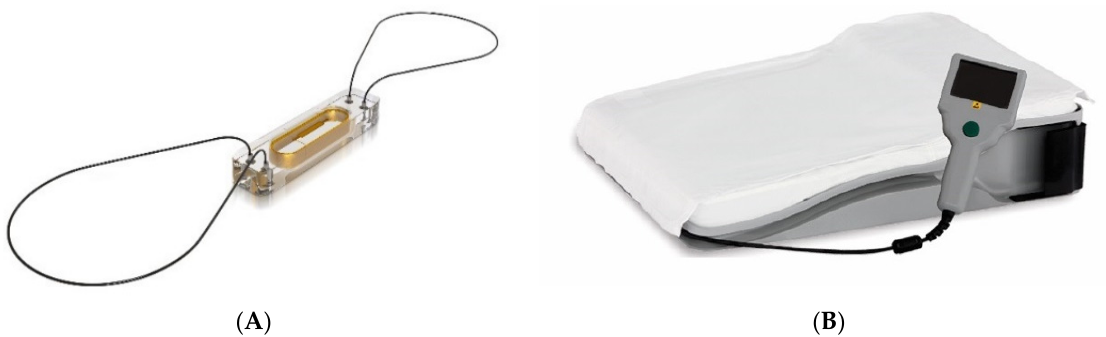
Figure 6. The CardioMEMS (Cardio-Microelectromechanical system) heart failure (HF) system, consisting of ( A ) The pulmonary artery pressure sensor and ( B ) the patient electronics unit to take daily pressure readings. Used with permission from Abbott Inc. (Abbott, Sylmar, CA, USA).